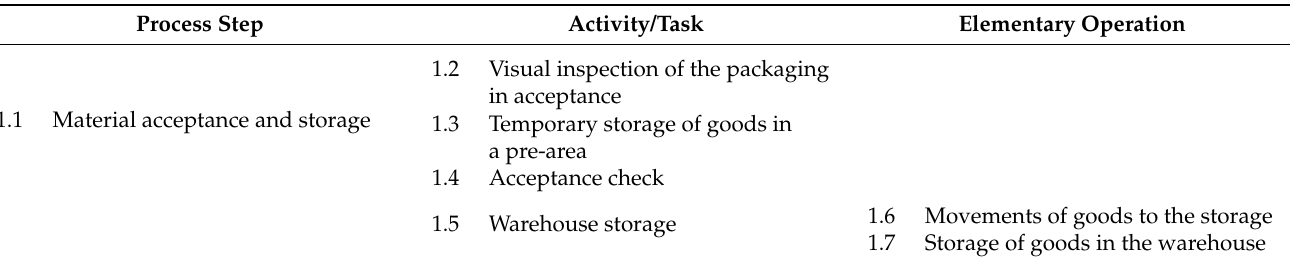
Table 1. Example of identification and decomposition of the specific steps for a process failure mode and effect analy- sis